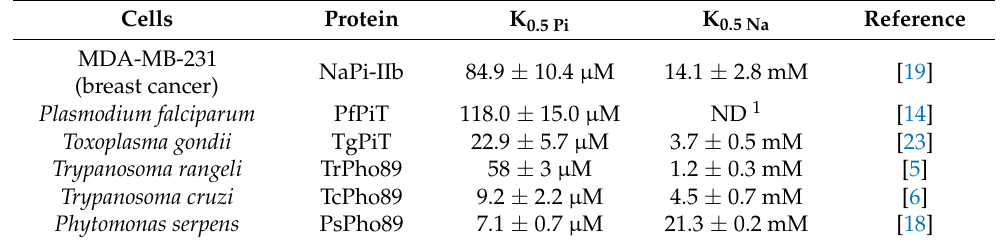
Table 1. Kinetic parameters of Na + -dependent Pi transporters in cancer and protozoan parasite cells.